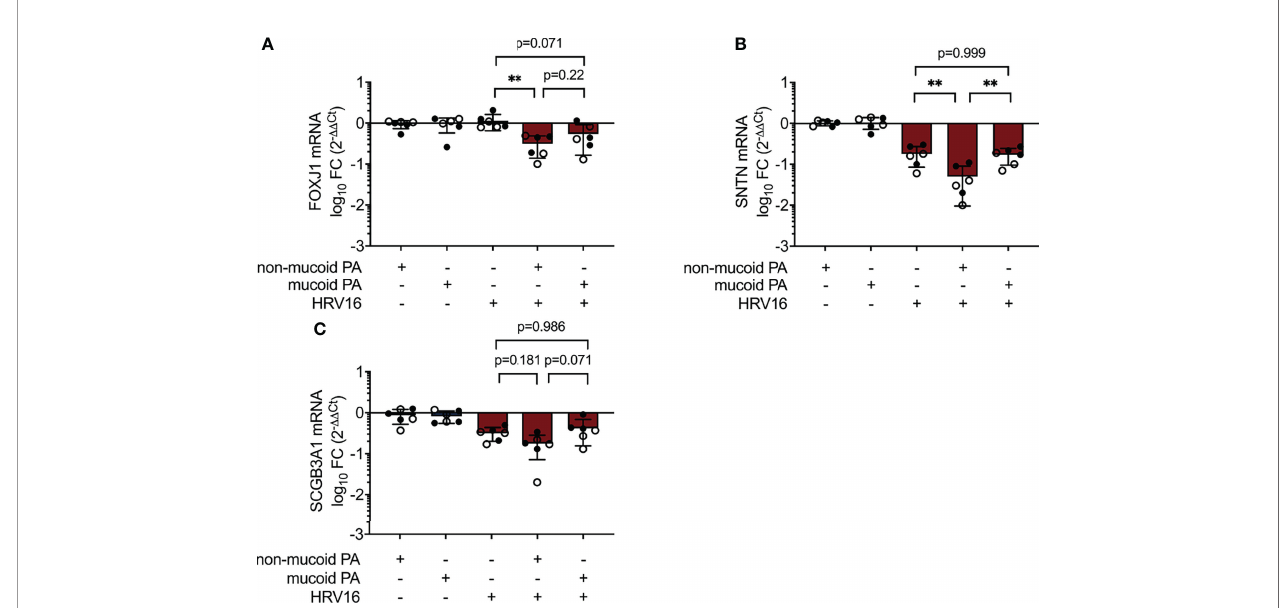
FIGURE 5 | Altered expression of differentiation-associated genes during PA/HRV co-infection. mRNA levels were assessed in cell lysates 48h post infection by RT qPCR. (A) Forkhead Box J1(FOXJ1) (B) Sentan, Cilia Apical Structure Protein (SNTN) (C) Secretoglobin Family 3A Member 1 (SCGB3A1). FC: fold change. Cell type, ○ Emphysema ● Cystic fi brosis. Data were obtained in six independent experiments, each performed with cells derived from a different donor. *p ≤ 0.05, **p ≤ 0.01, ***p ≤